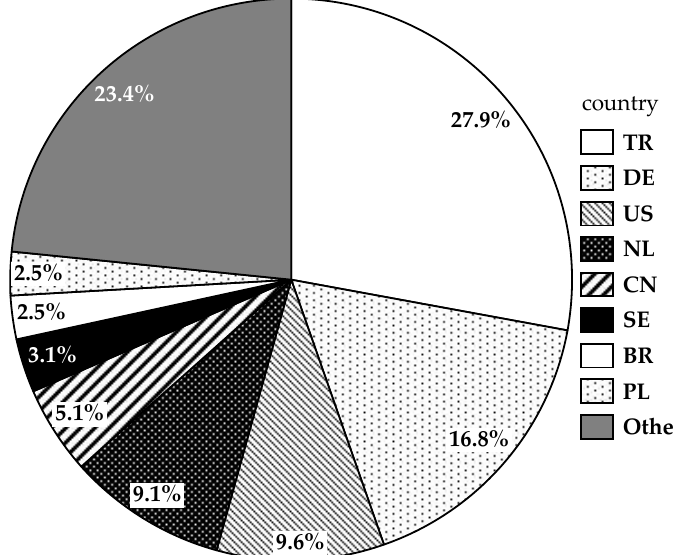
Figure 2. Country distribution .